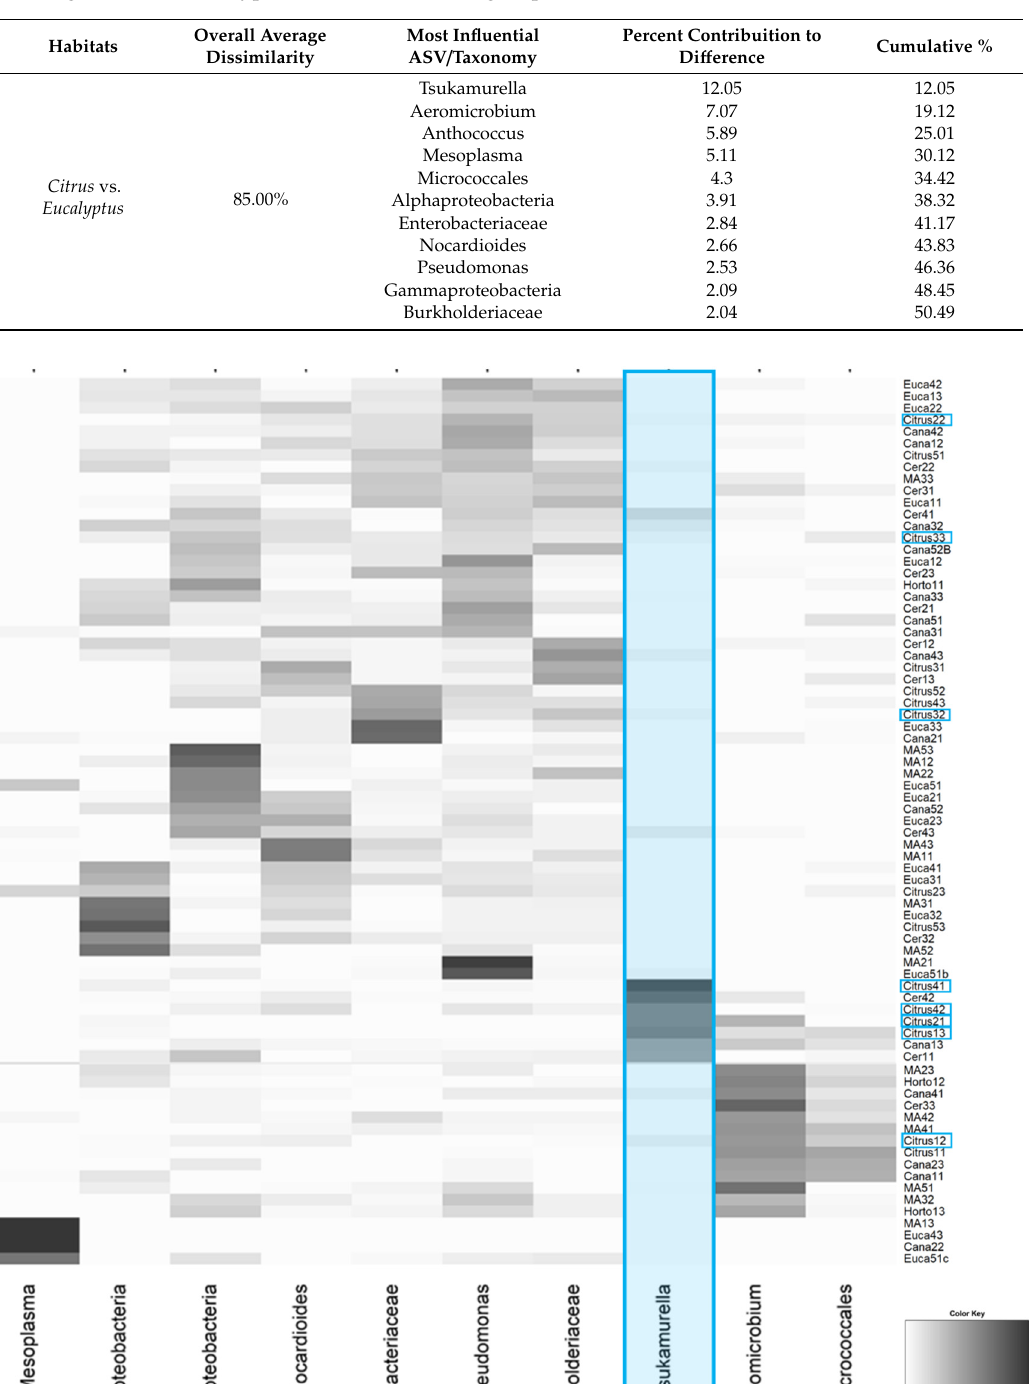
Table 1. Similarity percentage (SIMPER) analysis of main bacteria in citrus and eucalyptus group. This test indicates the contribution of specific ASVs to the observed di ff erences in community structure among citrus and eucalyptus. Note that for this group, Tsukamurella is the most influential bacteria.